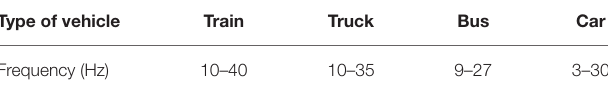
TABLE 2 | Threshold limits of PPV for different structures due to traffic vibrations (Amick and Gendreau,